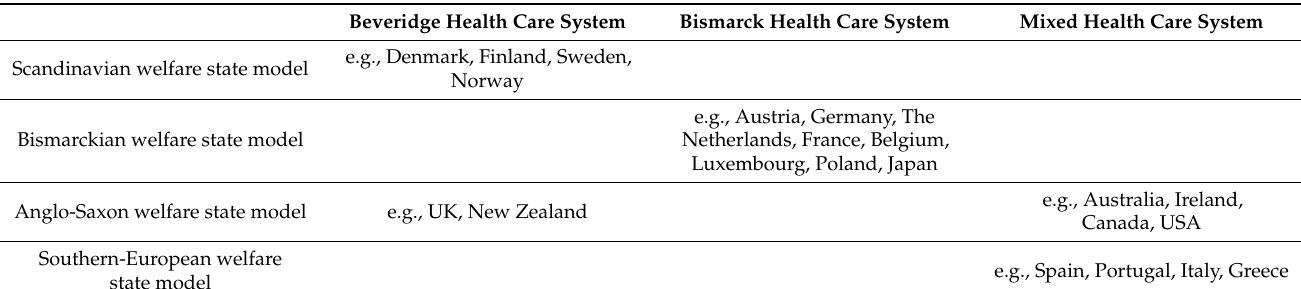
Table 1. Relations among welfare state and health care